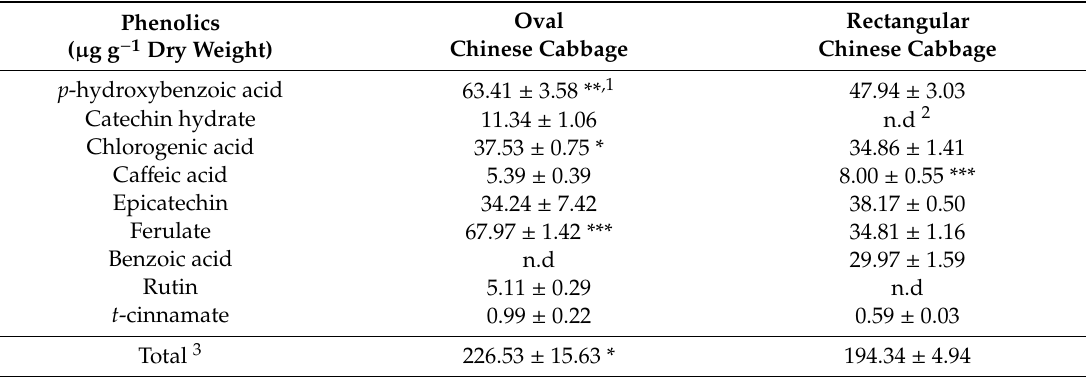
Table 2. Phenolic contents in oval and rectangular Chinese cabbage.